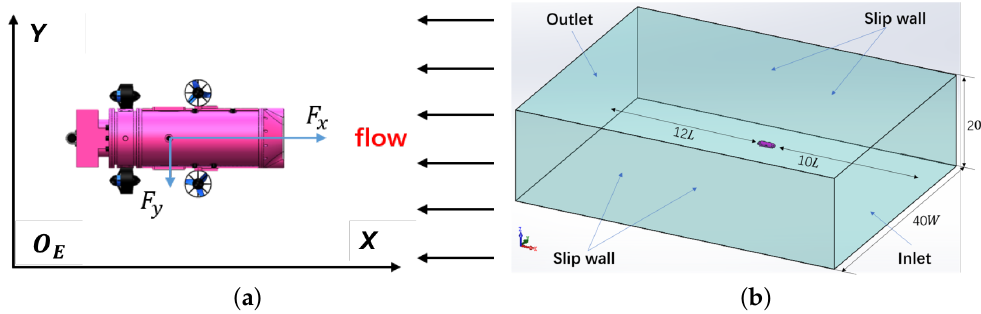
Figure 5. ( a ) Schematic of towing test of the underwater vehicle along the x -direction. ( b ) Computa- tional fluid domain designed for the towing test simulation.